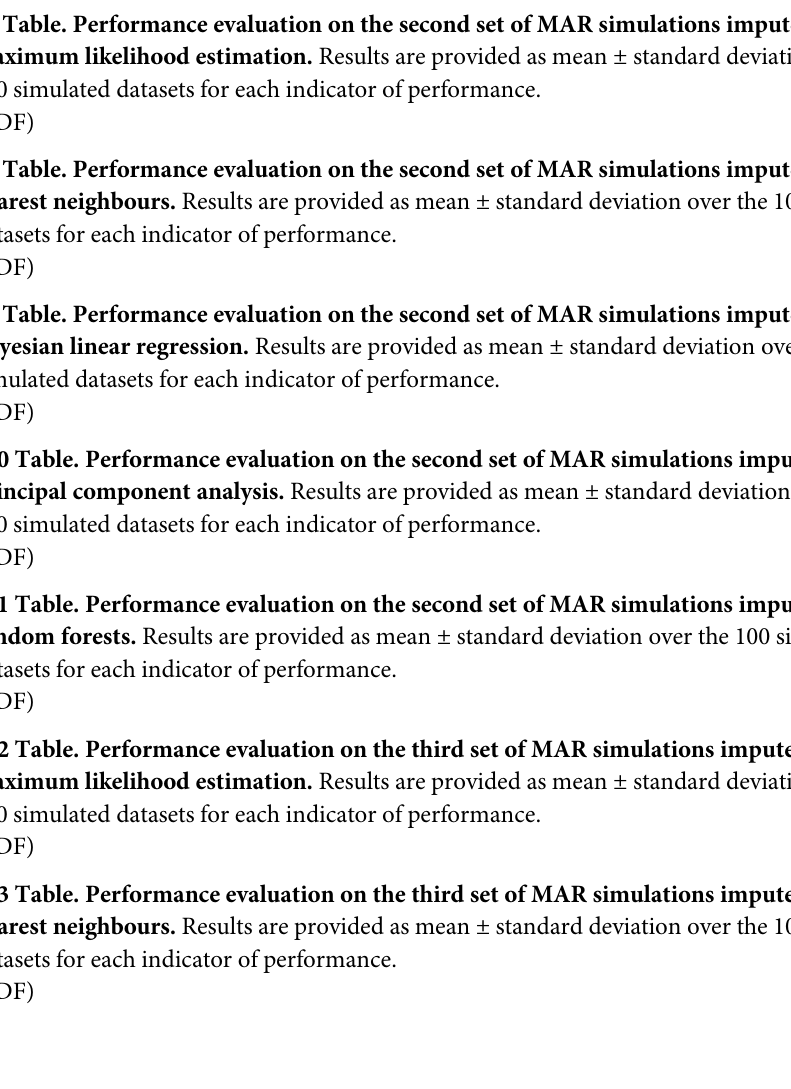
S4 Table. Performance evaluation on the first set of MAR simulations imputed using Bayesian linear regression. Results are provided as mean ± standard deviation over the 100 simulated datasets for each indicator of performance. S5 Table. Performance evaluation on the first set of MAR simulations imputed using prin- cipal component analysis. Results are provided as mean ± standard deviation over the 100 simulated datasets for each indicator of performance. S6 Table. Performance evaluation on the first set of MAR simulations imputed using ran- dom forests. Results are provided as mean ± standard deviation over the 100 simulated data- sets for each indicator of performance. S7 Table. Performance evaluation on the second set of MAR simulations imputed using maximum likelihood estimation. Results are provided as mean ± standard deviation over the 100 simulated datasets for each indicator of performance. S8 Table. Performance evaluation on the second set of MAR simulations imputed using k - nearest neighbours. Results are provided as mean ± standard deviation over the 100 simulated datasets for each indicator of performance. S9 Table. Performance evaluation on the second set of MAR simulations imputed using Bayesian linear regression. Results are provided as mean ± standard deviation over the 100 simulated datasets for each indicator of performance. S10 Table. Performance evaluation on the second set of MAR simulations imputed using principal component analysis. Results are provided as mean ± standard deviation over the 100 simulated datasets for each indicator of performance. S11 Table. Performance evaluation on the second set of MAR simulations imputed using random forests. Results are provided as mean ± standard deviation over the 100 simulated datasets for each indicator of performance. S12 Table. Performance evaluation on the third set of MAR simulations imputed using maximum likelihood estimation. Results are provided as mean ± standard deviation over the 100 simulated datasets for each indicator of performance. S13 Table. Performance evaluation on the third set of MAR simulations imputed using k - nearest neighbours. Results are provided as mean ± standard deviation over the 100 simulated datasets for each indicator of